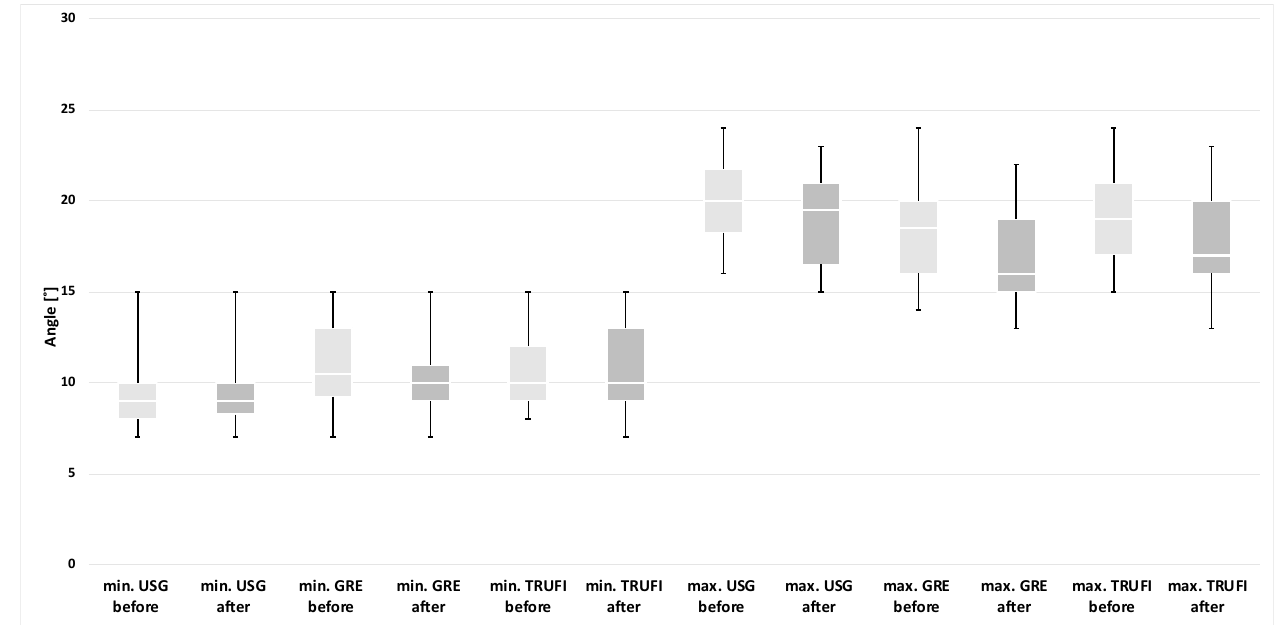
Figure 4. The minimum and maximum values of the glottic angles in the group of paralyzed vocal folds after surgery in relation to the preoperative examination with the use of US and MRI sequences (GRE and TRUFI). * p < 0.05.